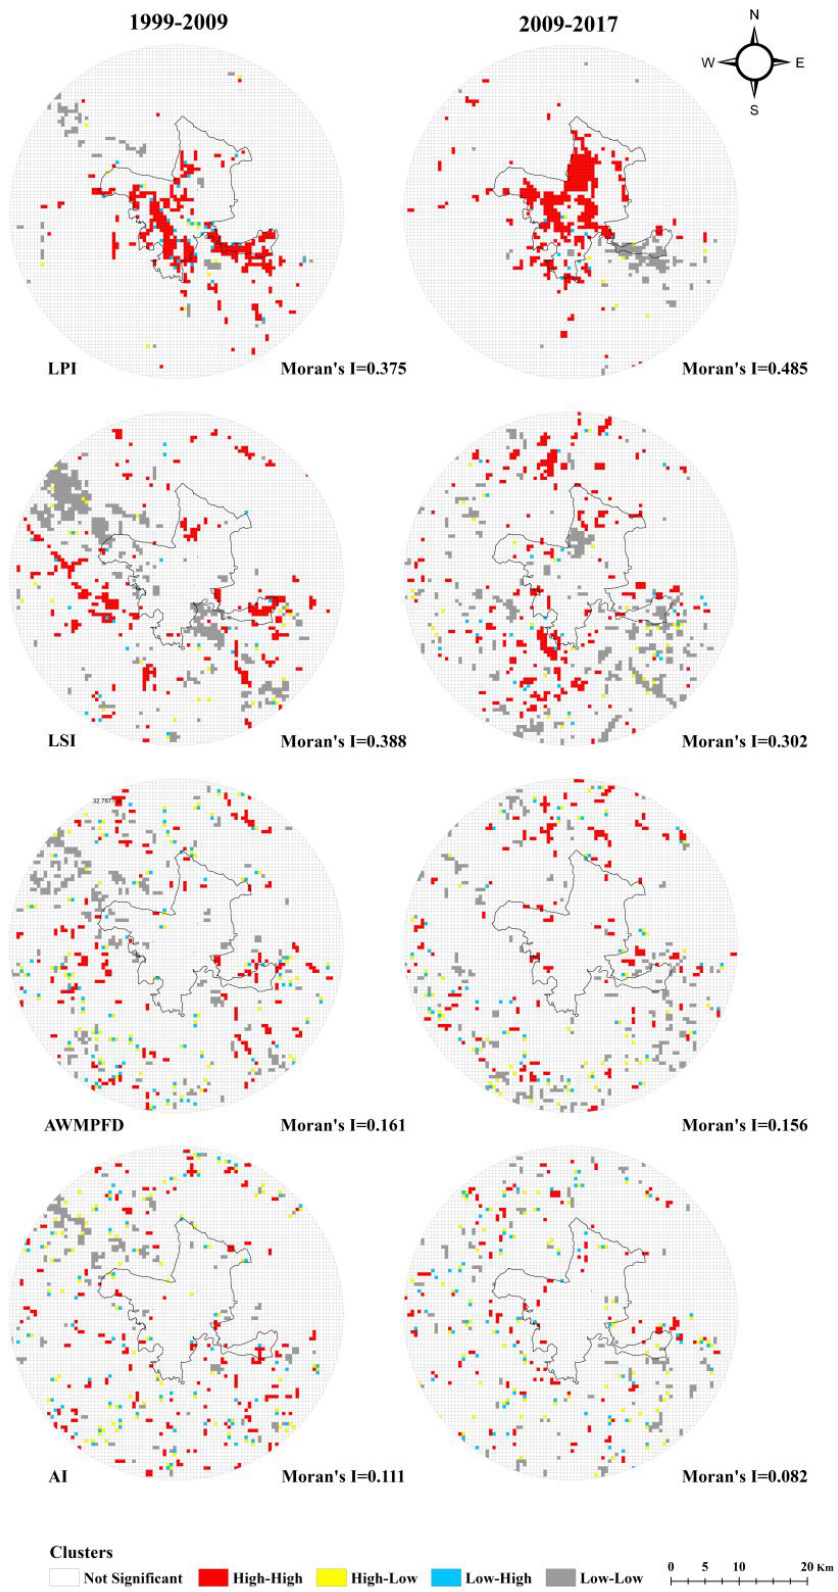
Figure 14. Spatial clusters of landscape metrics changes at 500 m cell-size between 1999–2009 and 2009–2017 identified through LISA along with their global Moran’s I